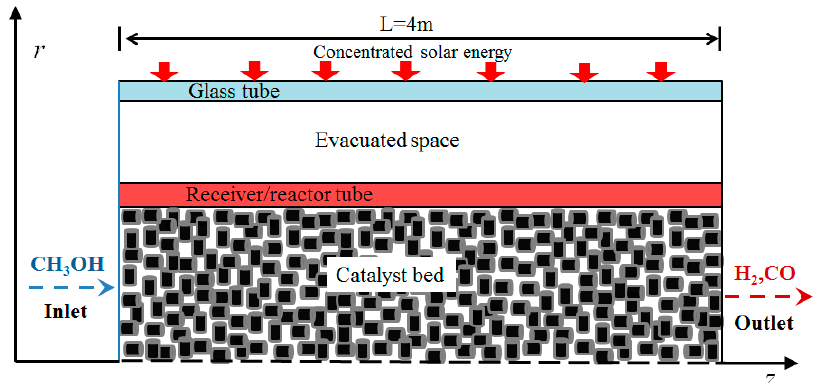
Figure 2. Coupling model of the MLTSRR.